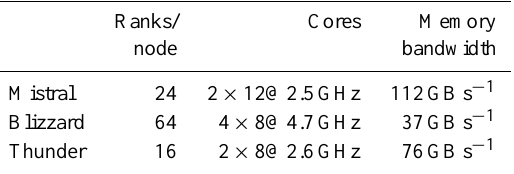
Table 1. Details on the computers used in this work. Mistral and Blizzard are Intel–Haswell and IBM Power6 supercomputers at DKRZ, Hamburg, respectively. Thunder denotes a Linux Cluster at ZMAW, Hamburg. Columns are the number of MPI ranks used per compute node, the number of sockets and cores, and the maxi- mum memory bandwidth per node as measured by the streams (Mc- Calpin, 1995) benchmark. Ranks/ Cores Memory node